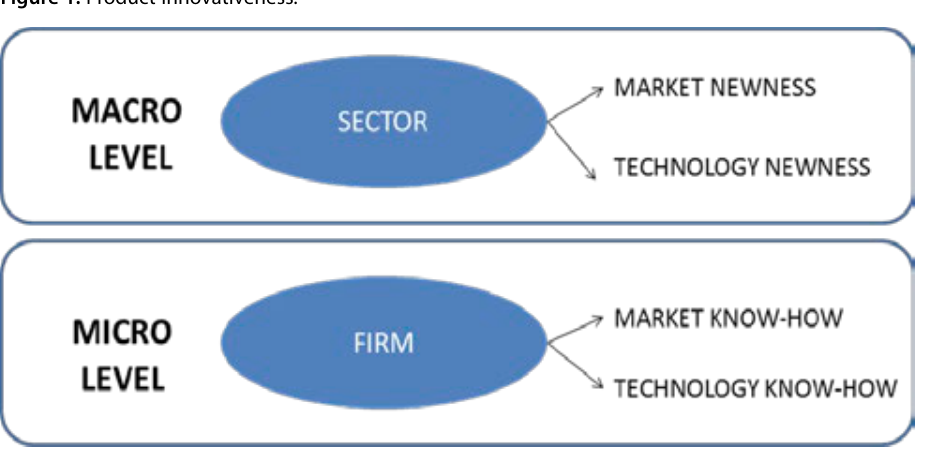
Figure 1. Product